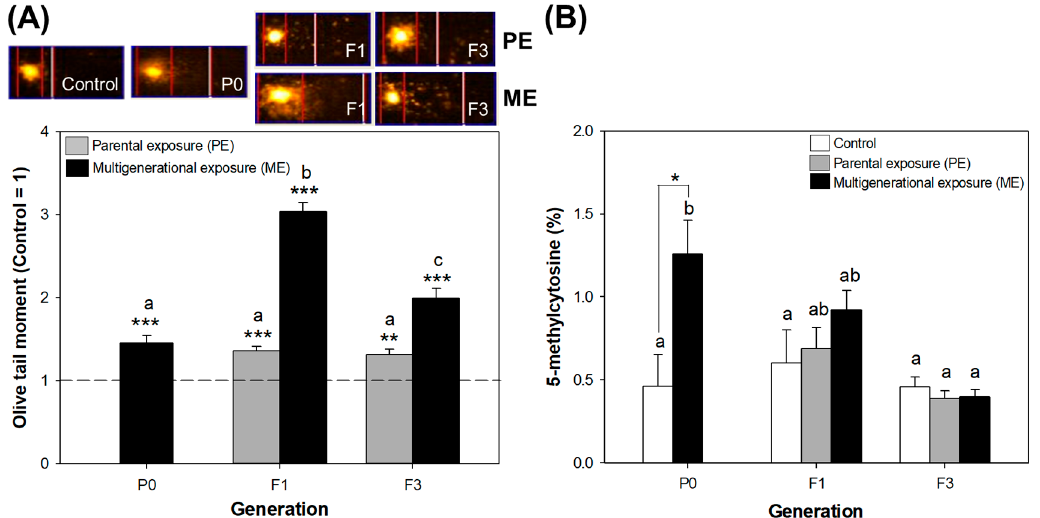
Figure 6. Genotoxic and epigenetic responses of daphnids to parental and multigenerational exposure to EC 20 CMIT/MIT: ( A ) Comparison of the measured DNA damage with the representative images of tail moment. ( B ) Comparison of % global DNA methylation. Asterisks indicate significant differences between the exposure and control groups: * p < 0.05, ** p < 0.01, and *** p < 0.001. Letters denote the homogeneity between groups (Bonferroni’s test).